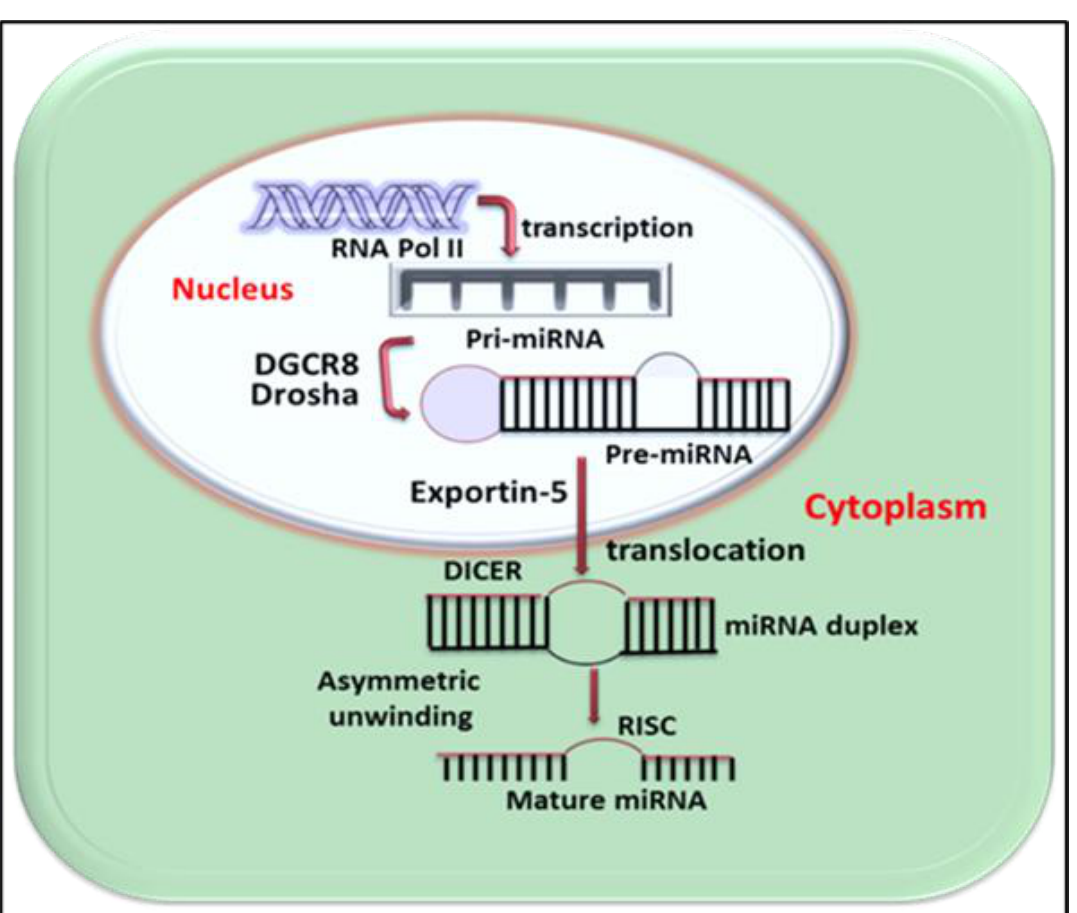
Figure 1. The schematic illustration of miRNA biogenesis and mechanism of action: in the nucleus of cells pri-miRNA are transcripted from DNA with help of RNA polymerase. The pri-miRNA is then cleaved by Drosha enzyme to pre-miRNA and moved into the cytoplasm by exportin-5 activity. The pre-miRNA is matured to miRNA via DICER. The mature strand of miRNA is integrated into the RNA-induced silencing complex (RISC) which inhibits the translation of the complementary